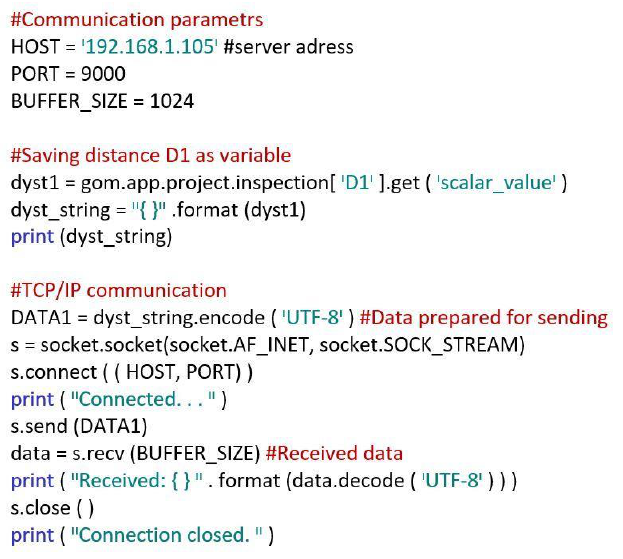
Figure 13. Definition of communication parameters.